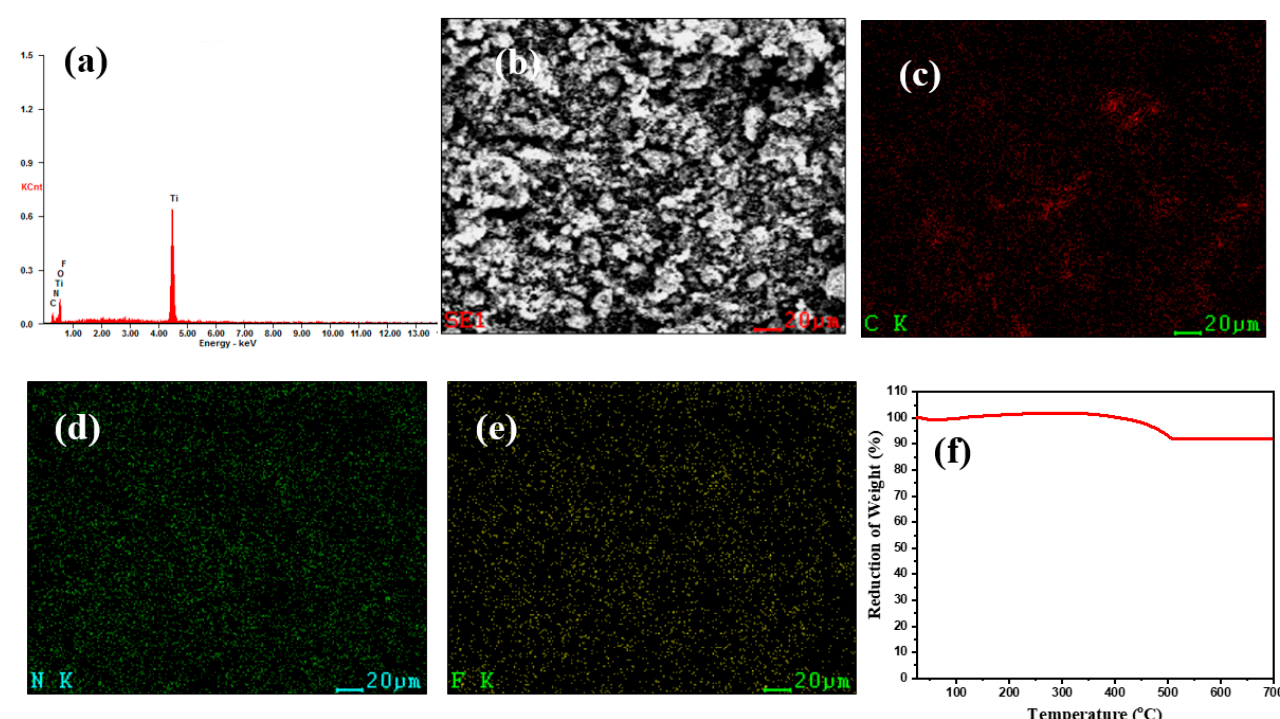
Figure 3. ( a ) EDS spectra, ( b – e ) SEM–EDS images and elemental mapping and ( f ) TGA of LTO